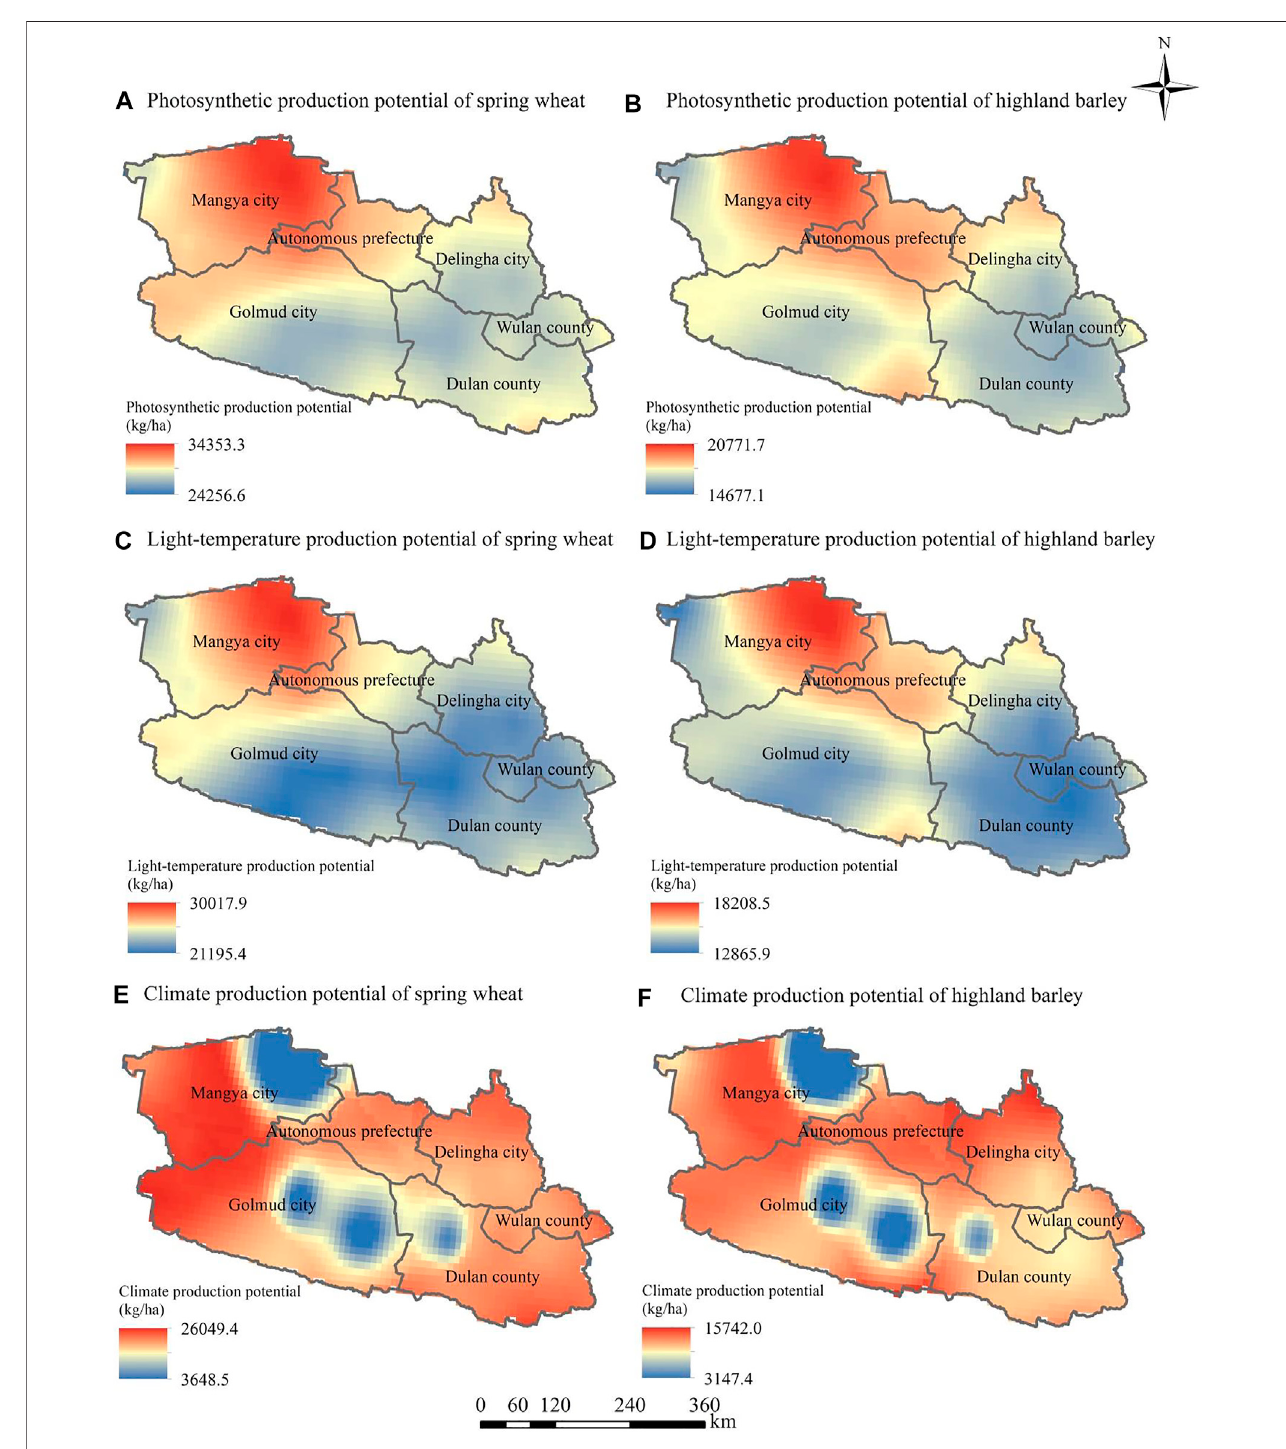
FIGURE6 | Photosynthetic, light-temperature and climate production potentialofspringwheat (A,C,E) , respectively and highland barley (B,D,F) , respectively. (A) Photosynthetic production potential of spring wheat (B) Photosynthetic production potential of highland barley (C) Light-temperature production potential of spring wheat (D) Light-temperature production potential of highland barley (E) Climate production potential of spring wheat (F) Climate production potential ofhighland barley.